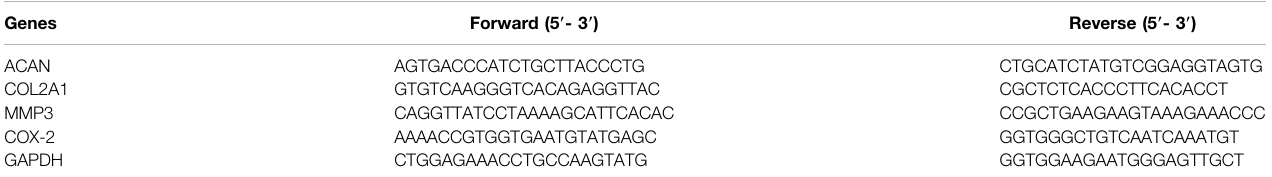
TABLE 1 | Primers used in RT-qPCR detection.